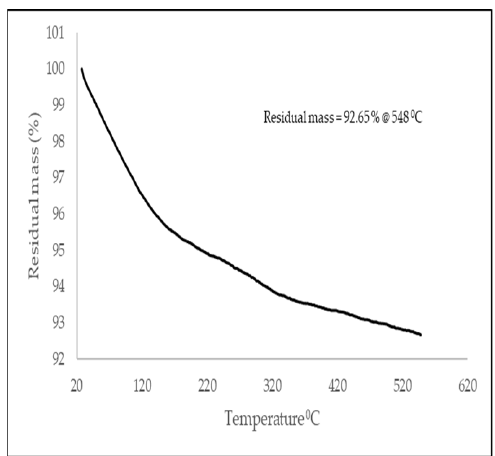
Figure 25. Thermogravimetric results of SRMB.